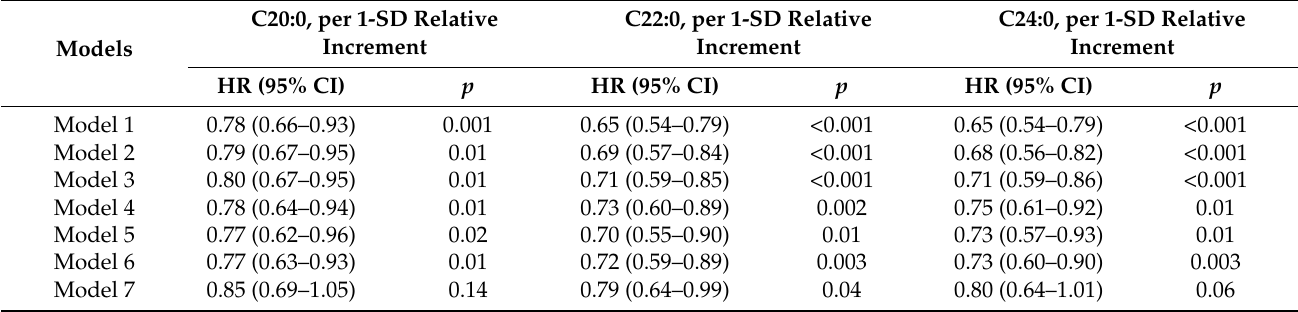
Table 3. Prospective analysis of standardized circulating VLSFA with all-cause mortality in